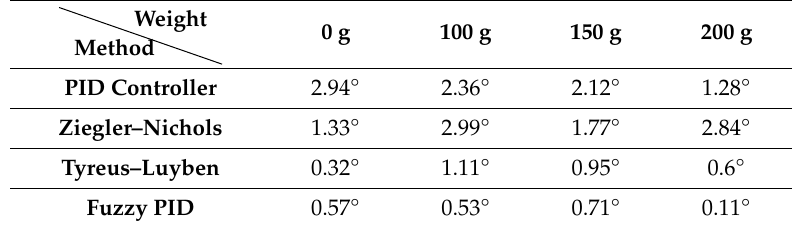
Table 8. Steady-state error in Experiment